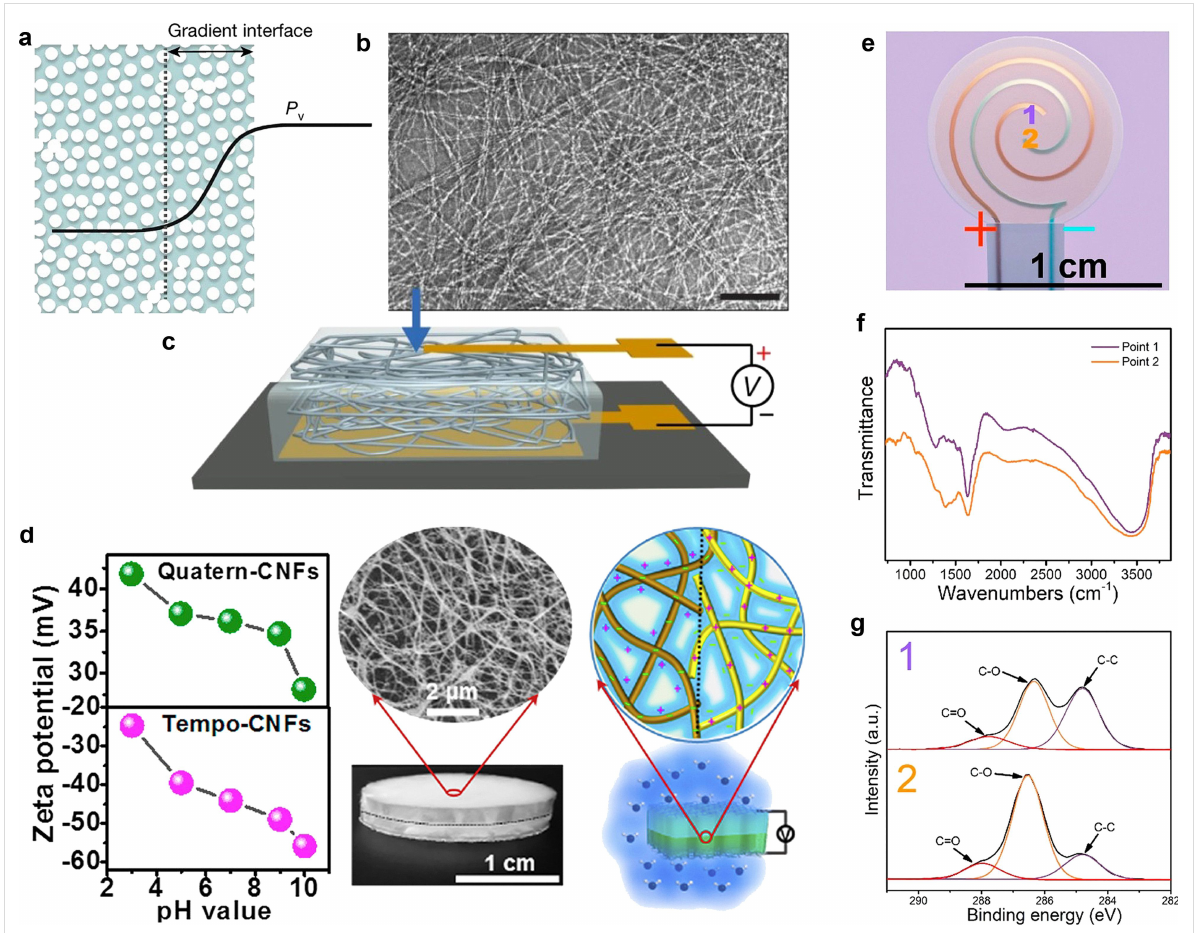
Figure 8: (a) Vapor pressure gradient near the air interface. (b) TEM images of the purified nanowire network. Scale bars: 100 nm. (c) Diagram of the protein device structure. Figure 8a–c are from [86] and were adapted by permission from Springer Nature from the journal Nature (“Power generation from ambient humidity using protein nanowires“ by X. Liu; H. Gao; J. E. Ward; X. Liu; B. Yin; T. Fu; J. Chen; D. R. Lovley; J. Yao), Copyright 2020 Springer Nature. This content is not subject to CC BY 4.0. (d) From left to right are the zeta potential values of two different CNFs, the SEM image of the nanostructure, and the schematic diagram of the heterostructure. Figure 8d was adapted from [85]. This article was published in Nano Energy, vol. 71, by W. Yang; X. Li; X. Han; W. Zhang; Z. Wang; X. Ma; M. Li; C. Li, “Asymmetric ionic aerogel of biologic nanofibrils for harvesting electricity from moisture“, article no. 104610, Copyright Elsevier (2020). This content is not subject to CC BY 4.0. (e) Schematic diagram of a fabricated power gener- ator with a g-PDA film and two spiral electrodes for (1) the anode and (2) the cathode. (f) Infrared spectra of g-PDA near (1) the anode and (2) the cathode. (g) High-resolution C 1s spectra of the g-PDA film for (1) the anode and (2) the cathode. Figure 8e–g were reprinted with permission from [84], Copyright 2019 American Chemical Society. This content is not subject to CC BY 4.0.